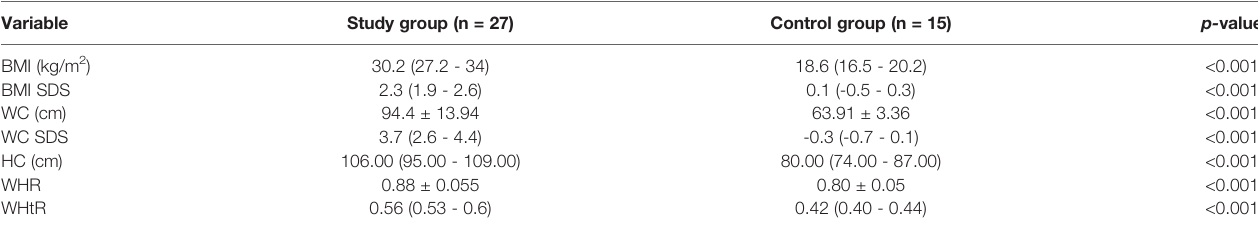
TABLE 1 | Characteristic of anthropometric measurements in overweight and obese children (study group) and normal weight children (control group).